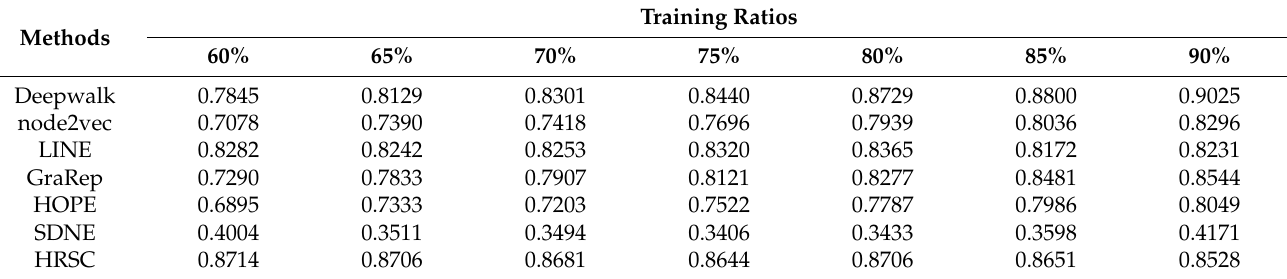
Table 6. AUC values on MovieLens.